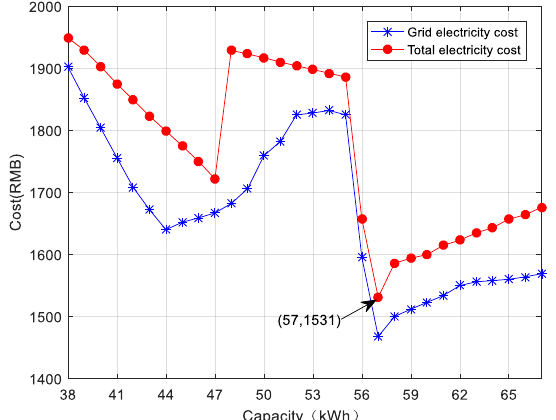
ff erent storage